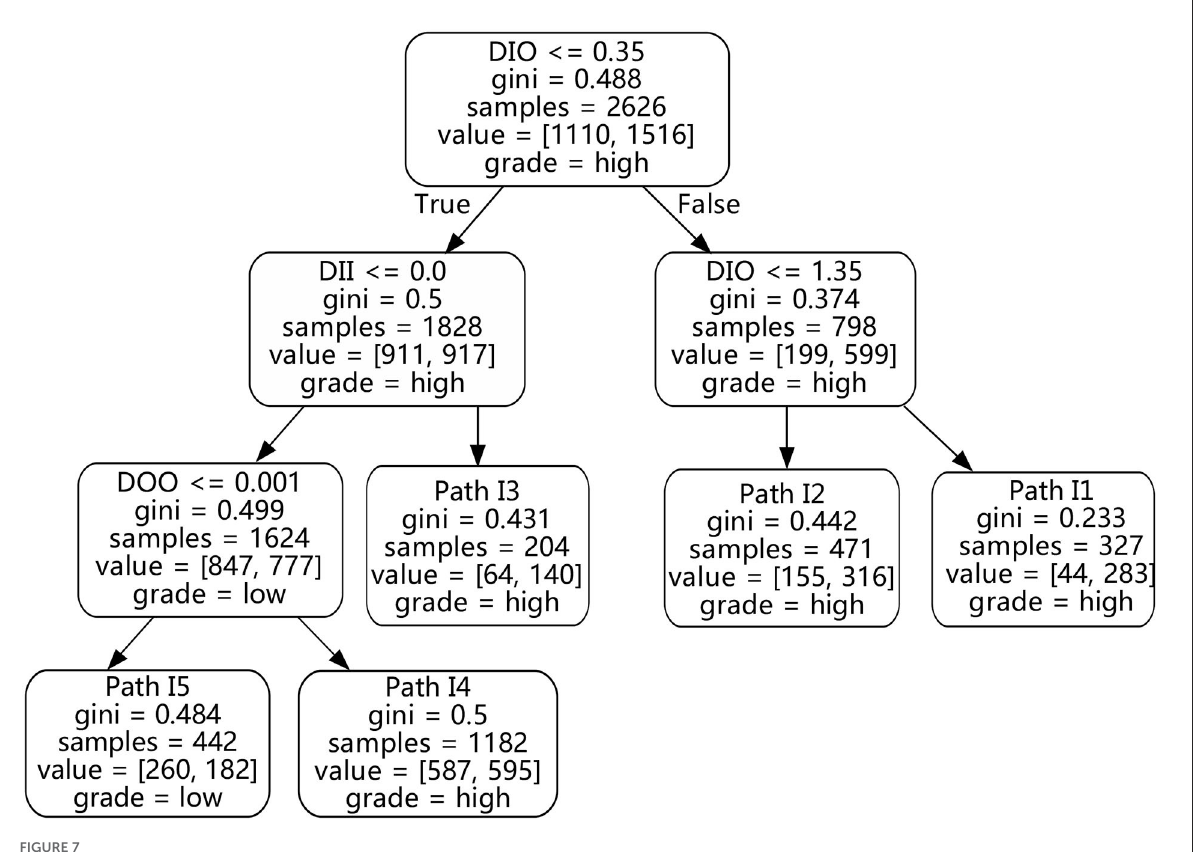
FIGURE7 Decision tree for excellent digitalization